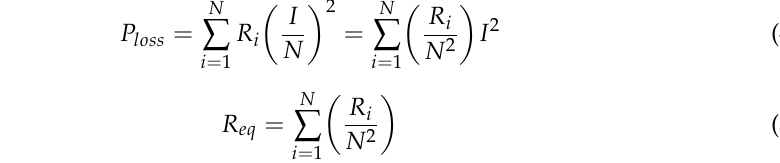
Figure 2. Battery storage unit configuration.